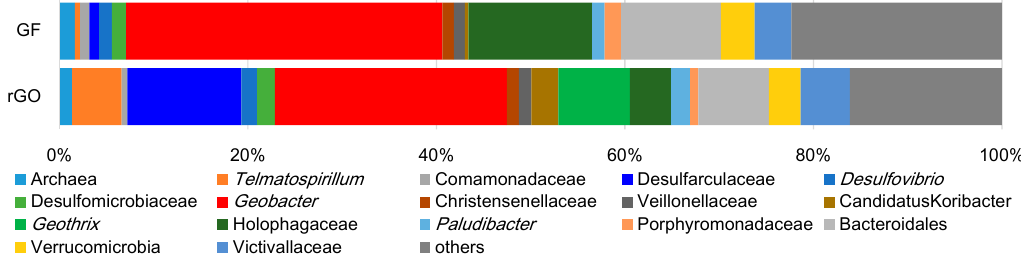
Figure 6. Microbial community structures in the rGO and GF complexes. The data were obtained from single experiments using complexes polarized for 30 days.